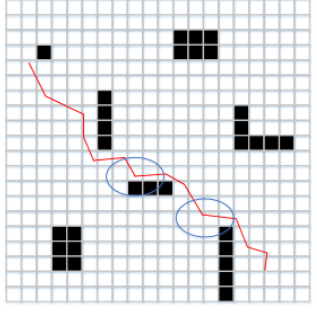
Figure 11. Collision avoidance